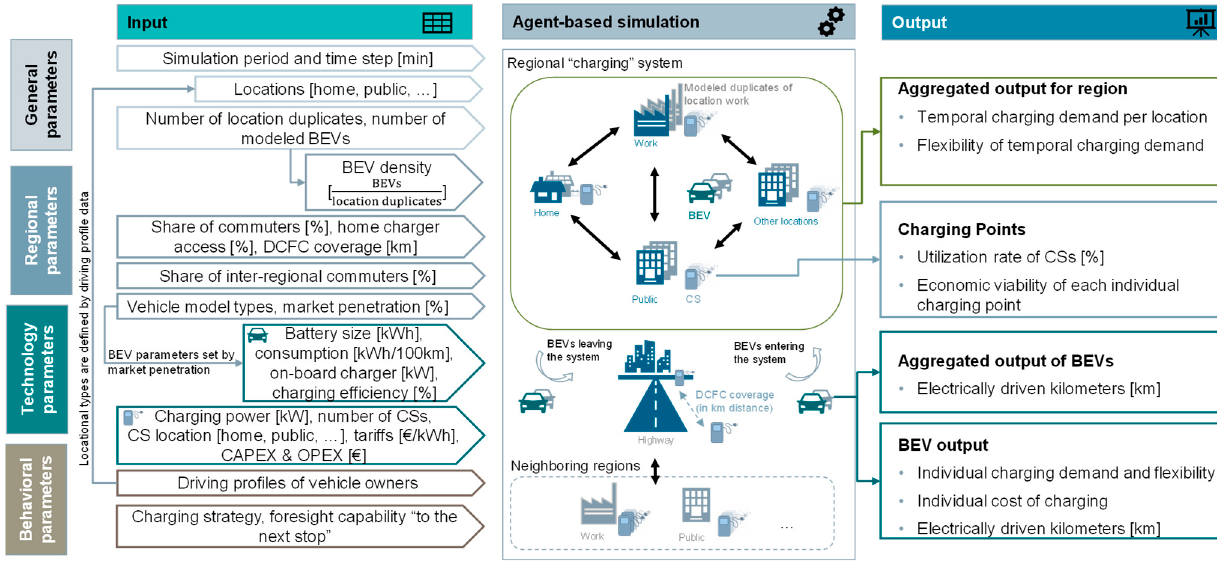
Figure 1. Model framework of Agent-based e-Mobility Model. Input Parameters